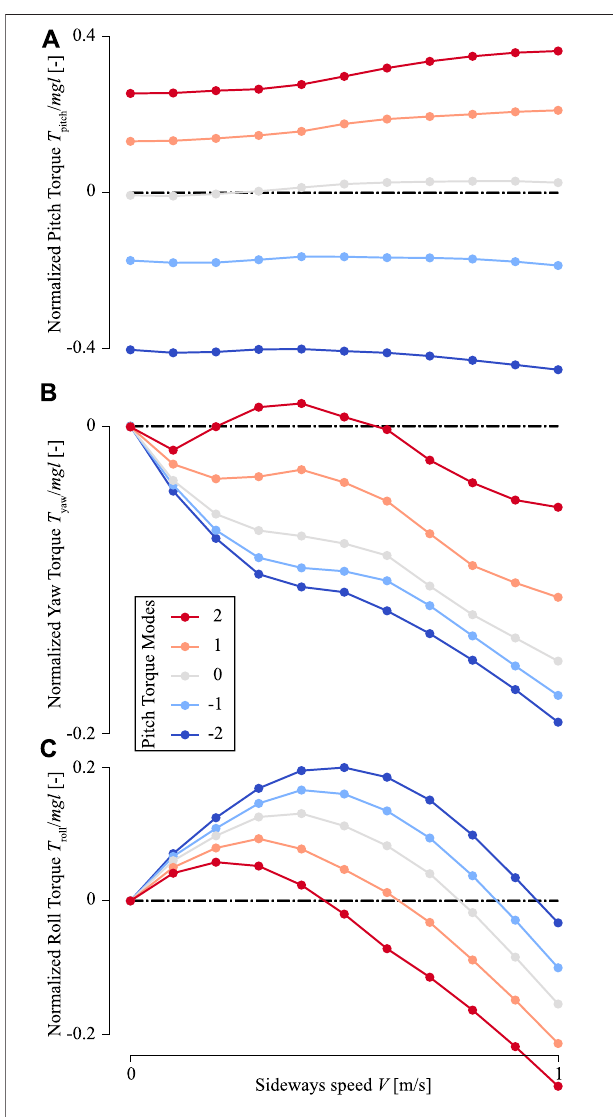
FIGURE9| Thewing-beat-averagetorquesproducedbyanin-silicafruit fl y fl ying sideways with variable pitch torque-producing wing-beat kinematics. (A – C) Pitch, yaw, and roll torques, respectively. Each panel shows torques determined using CFD (ordinate) as a function of sideways fl ight speed (abscissa) and wing-beat kinematics (color-code, see legend). Each data point shows the wing-beat-average torque resulting from a single CFD simulation. All torques are normalized with the order-of-magnitude of the weight and size of an average fruit fl y.